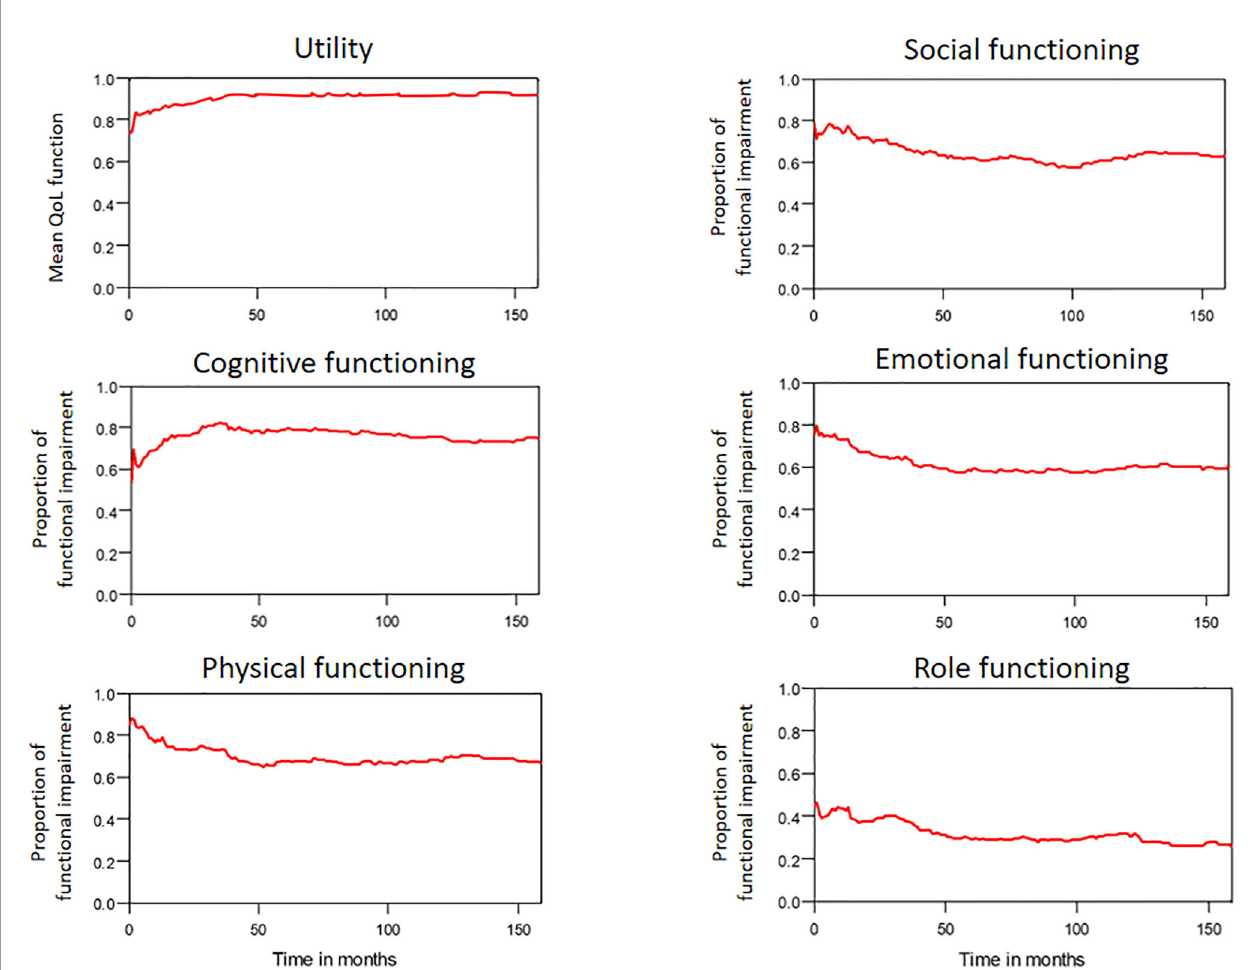
FIGURE 7 | The trends of mean QoL (utility) function and functional impairments in patients with